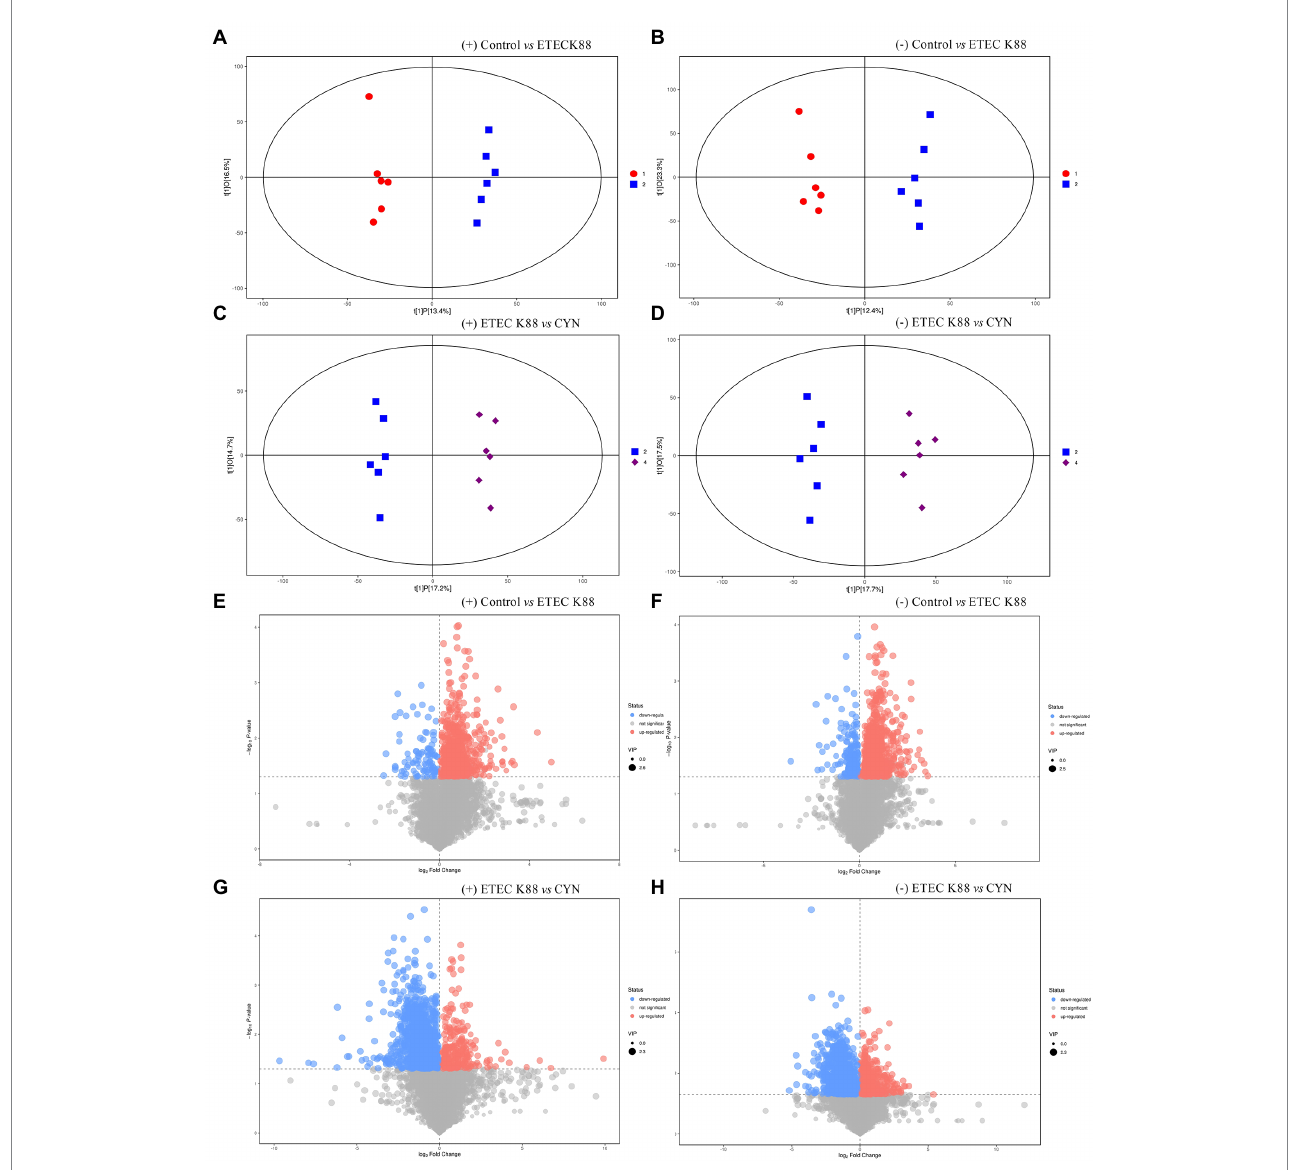
FIGURE 5 LC/MS metabolite principal component analysis and metabolite differences between groups. (A,B) OPLS-DA score plots based on the ESI (+) and ( − ) mode (Control vs. ETEC K88). (C,D) OPLS-DA score plots based on the ESI (+) and ( − ) mode (ETEC K88 vs. CYN). (E,F) Volcano plot based on the ESI (+) and ( − ) mode (Control vs. ETEC K88). (G,H) Volcano plot based on the ESI (+) and ( − ) mode (ETEC K88 vs. CYN). Metabolites with significantly up-regulated expression were in red, down-regulated expression were in blue, non-significant expression were in gray. In the picture, 1 represents Control group, 2 represents ETEC K88 group, 4 represents CYN